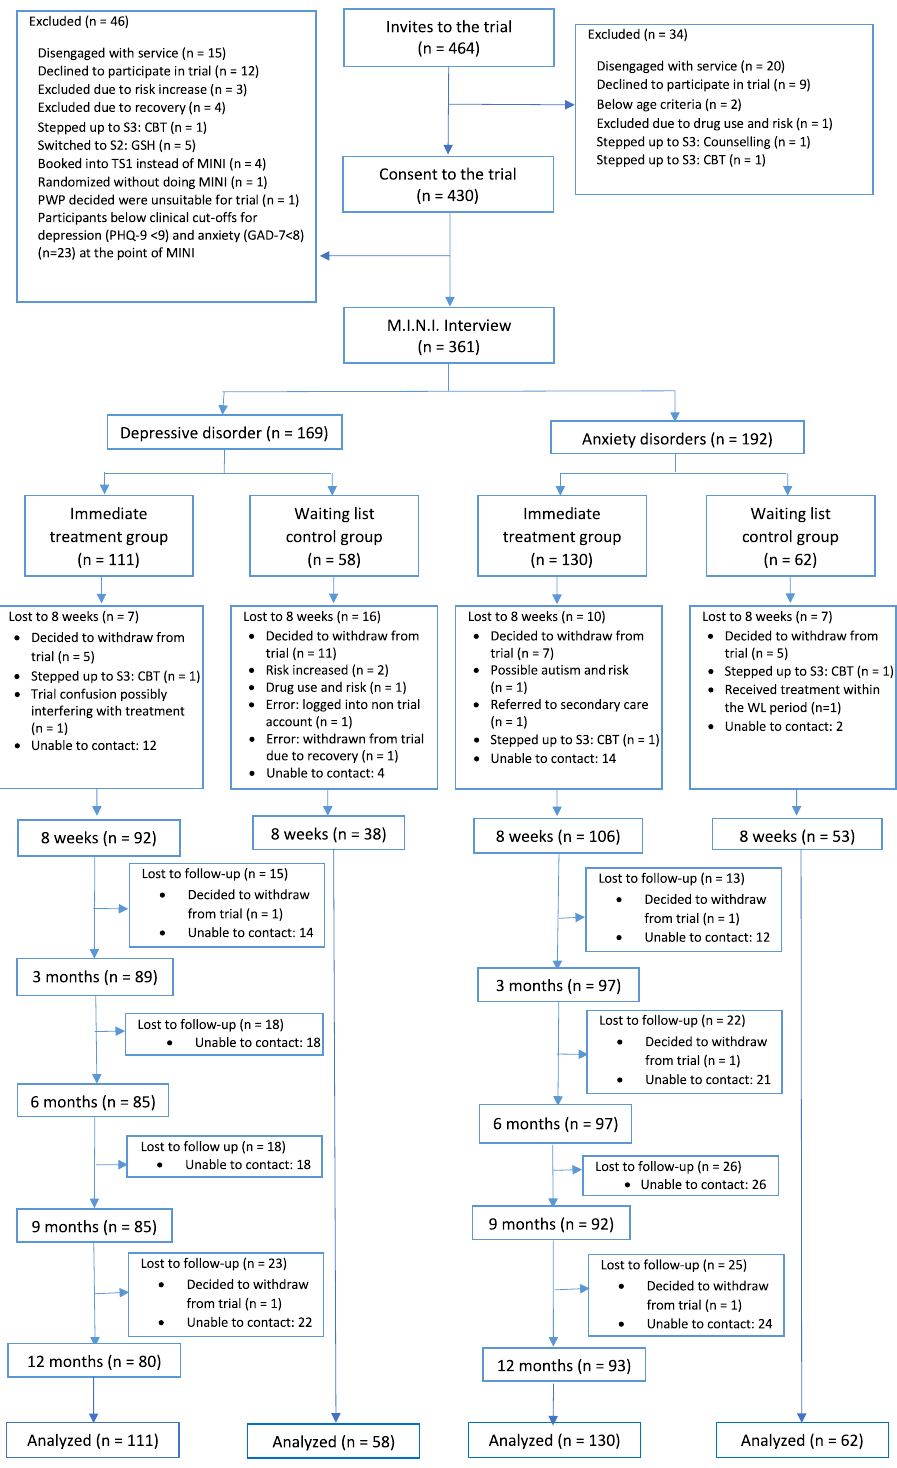
Fig. 1 Flowchart of participants – CONSORT. CBT Cognitive Behavioural Therapy; GSH Guided Self-Help; MINI Mini International Neuropsychiatric Interview 7.0.2 (M.I.N.I.7.0.2); PHQ-9 Patient-Health Questionnaire-9; GAD-7 Generalised Anxiety Disorder-7; S2 Step 2 IAPT; S3 step 3 IAPT; PWP Psychological Wellbeing Practitioners; TS1 Telephone Screening